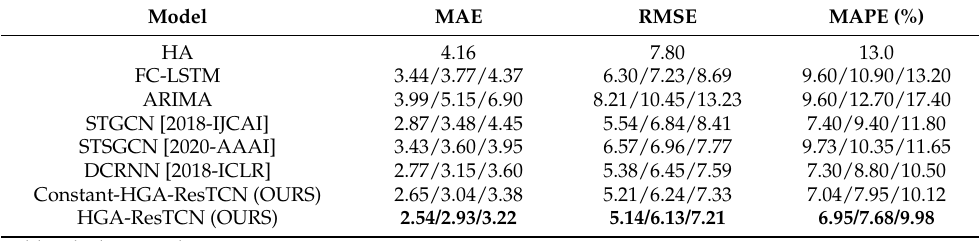
Table 2. The METR-LA dataset comparison with other baselines in the next 15, 30, and 60 min.